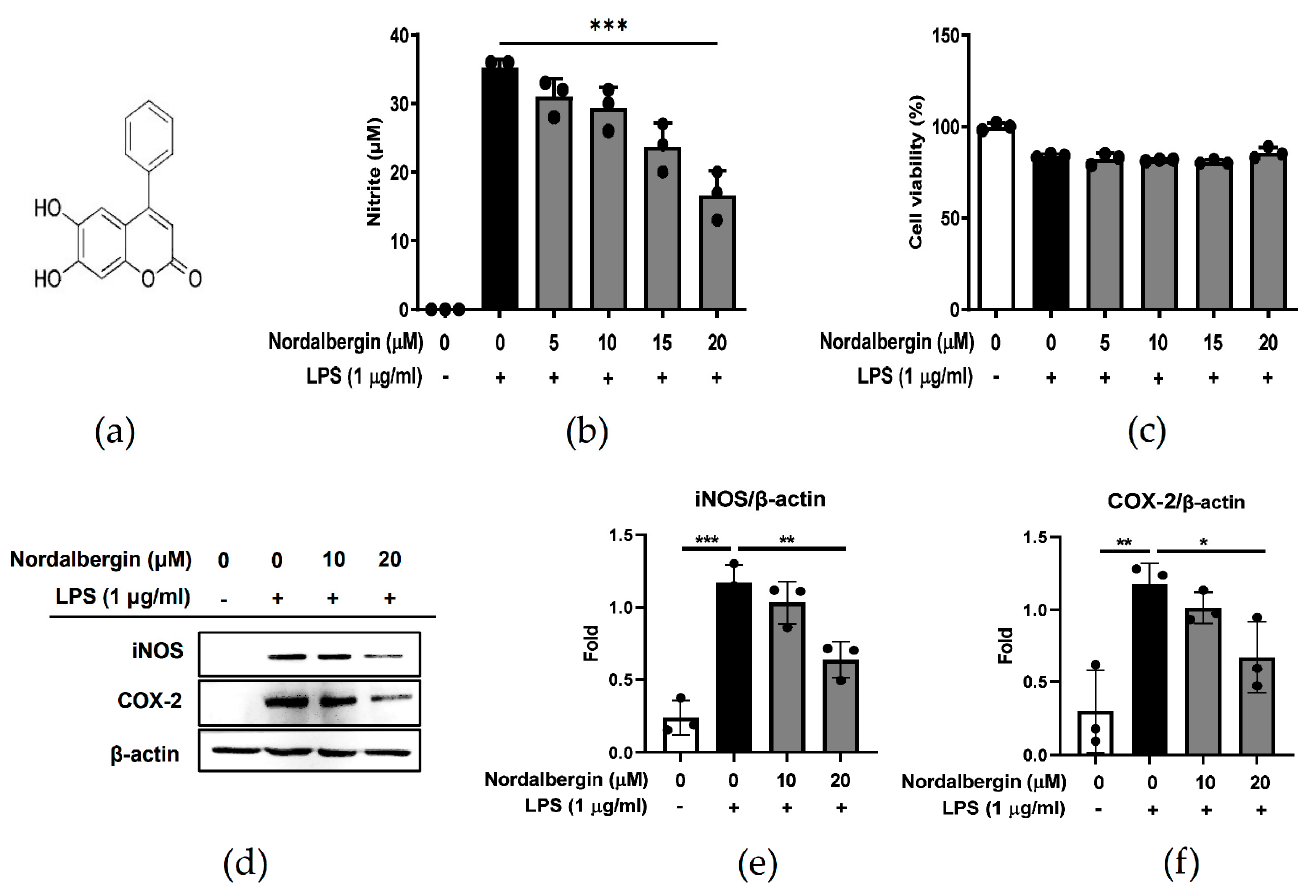
Figure 1. E ff ect of nordalbergin on the NO production, iNOS and COX-2 expression, and cell viability by LPS-stimulated BV2 cells. ( a ) The chemical structure of nordalbergin (M.W. 254.24). BV2 cells were pretreated with nordalbergin (0–20 µM) for 30 min and then primed with LPS for 24 h. ( b ) Production of NO was analyzed using Griess reagent assay. ( c ) Cell viability was detected using MTT assay. ( d ) iNOS and COX-2 expressions were measured by Western blot, while β -actin expression was used as a loading control. Quantitative results are shown in ( e , f ). Data are shown as mean ± standard deviation (SD) of three independent replicates (* p < 0.05, ** p < 0.01, *** p < 0.01).